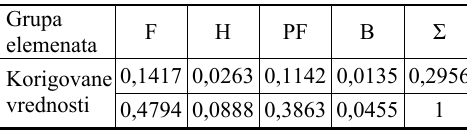
Grupe elemenata sa koeficijentima nakon korekcije vrednosti zbog nejednakog broja podgrupa Grupa